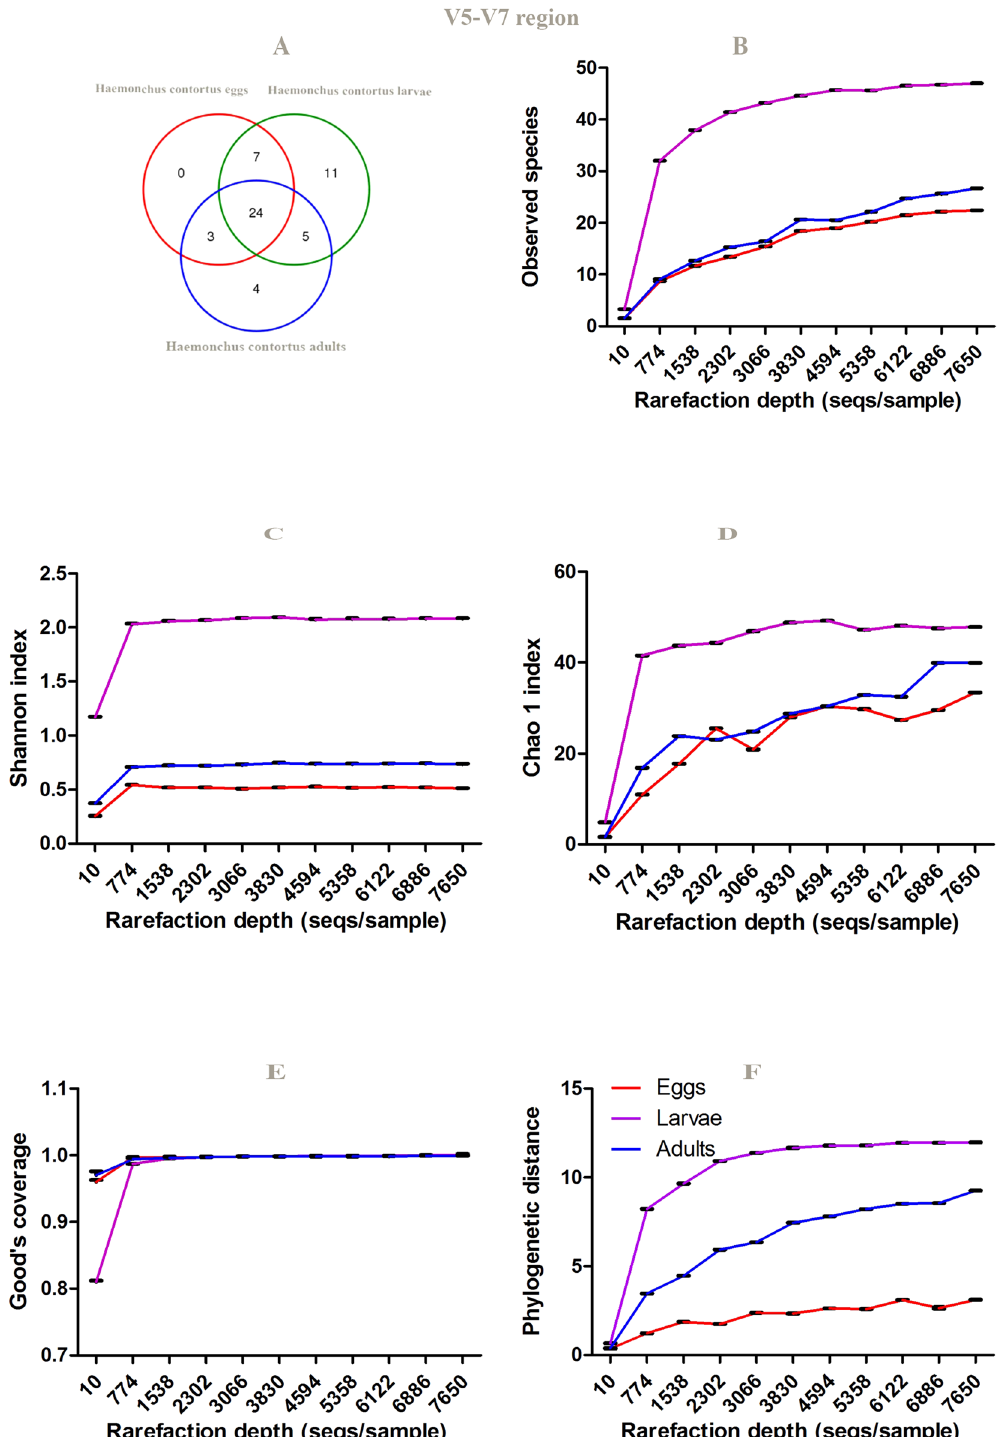
Figure 8. Venn graph ( A ) and alpha diversity analysis ( B–F ) of H. contortus eggs, larvae and adults based on 16S rRNA gene sequence (V5-V7 region) of parasite microbiome and 97% identity. Rarefraction curve for ( B ). observed species ( C ). Shannon, ( D ). Chao1, ( E ). good’s coverage and ( F ). PD whole tree. Data represent average values from pooled populations (i.e from each sheep) of eggs/larvae/adults (male and female) come from three different